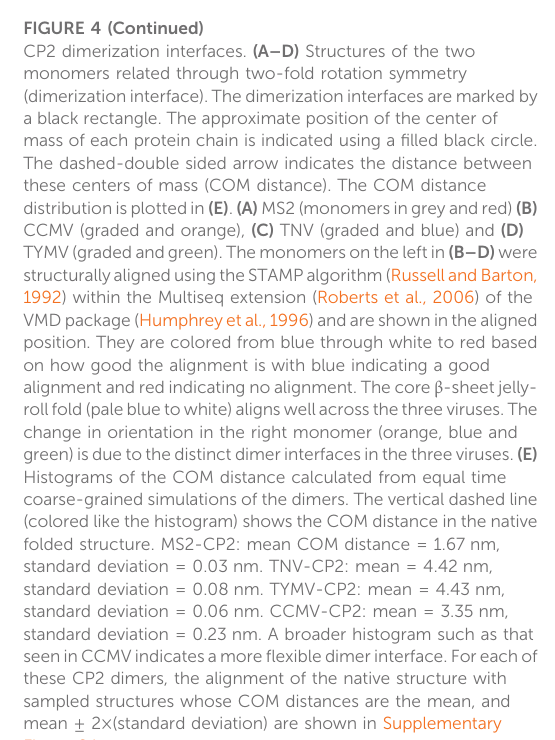
sampled structures whose COM distances are the mean, and mean ± 2×(standard deviation) are shown in